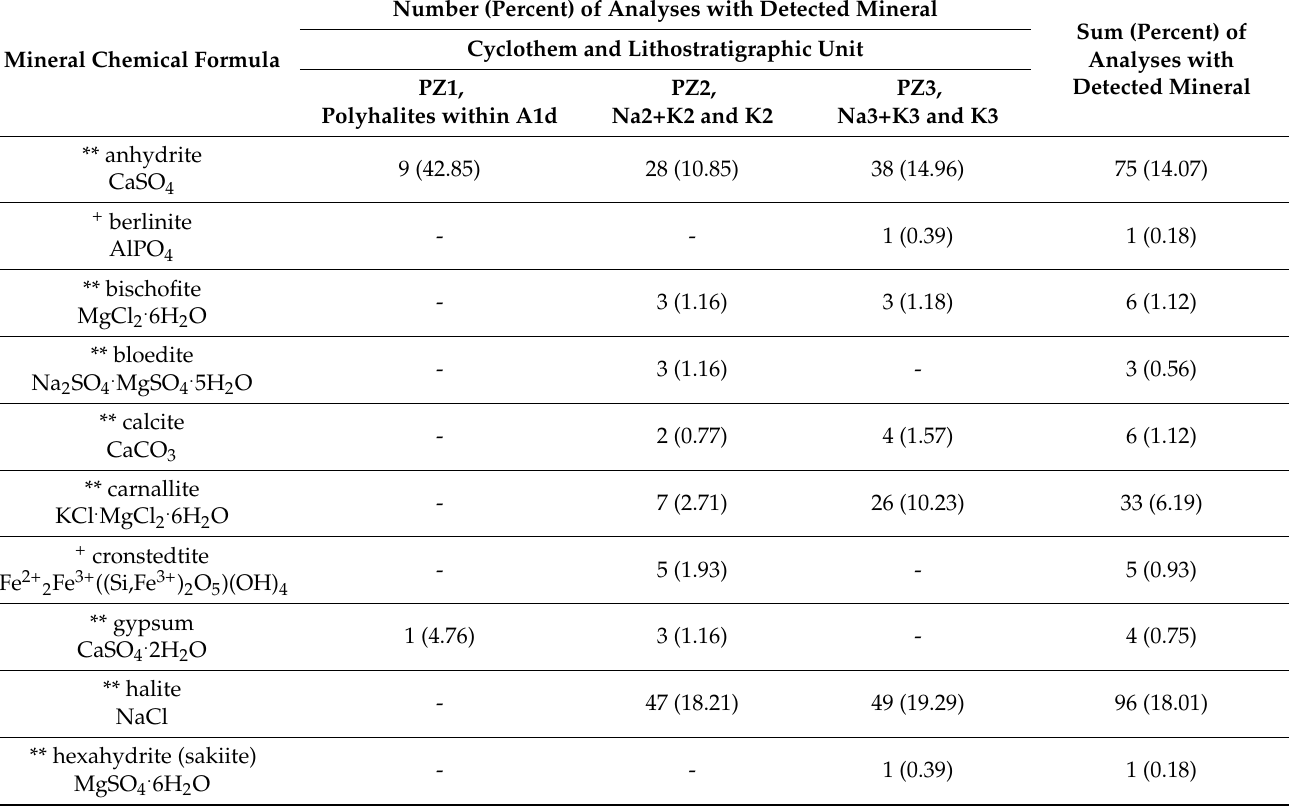
Table 4. Frequency of detected main minerals in the Upper Permian (Zechstein) potash-bearing deposits of Poland (PZ1, PZ2 and PZ3